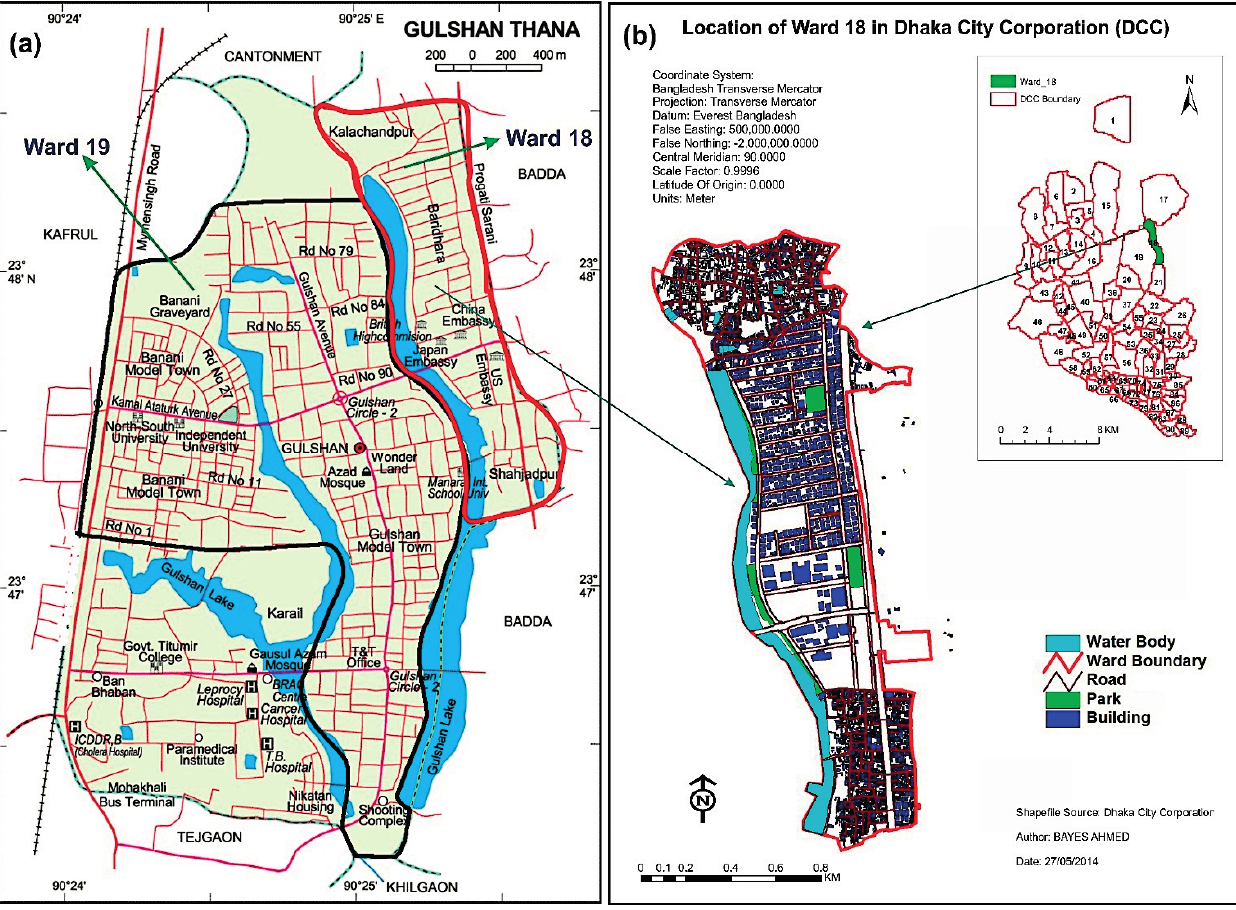
Figure 5. Location of ward 18 ( a ) in Gulshan thana and ( b ) in DCC. Source: (a) Banglapedia , National Encyclopedia of Bangladesh,